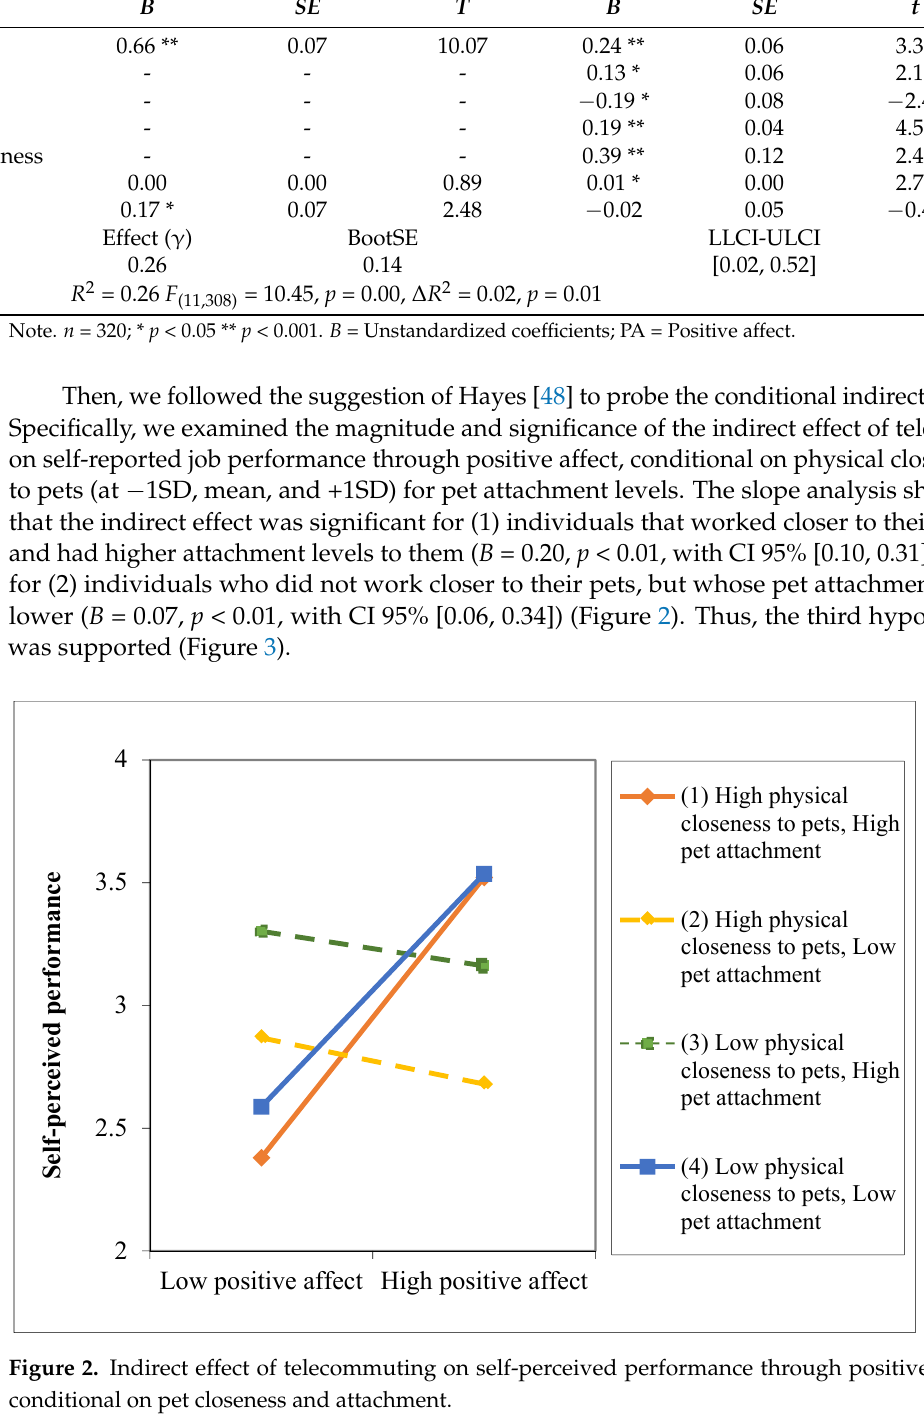
Figure 3. The moderated moderated mediation model with the results. 6. Discussion The present study examined the role of positive affect on the self-reported job performance of teleworkers highlighting the importance of pet physical and emotional closeness on job performance of them. This study answers the call of studies from [9] to explore the benefits of pets for performance outcomes. Specifically, this study aimed to contribute to understanding the process and the conditions through which telecommuting improves self-reported job performance. First, the results show that the attitude toward telecommuting is positively associated with self-perceived job performance, that is, while telecommuting workers appear to consider having a positive performance. This result is in line with other studies that have shown a positive effect of working from home on job performance [43]. Second, the results show that the attitude toward telecommuting improves positive affect which in turn enhances self-reported job performance. That is when individuals show higher levels of perceived life quality while teleworking, this tends to positively influence positive affect while working which in turn promotes self-reported job performance. This result is supported from a social exchange perspective. Accordingly, individuals tend to behave by weighing the costs and benefits that they expect to receive